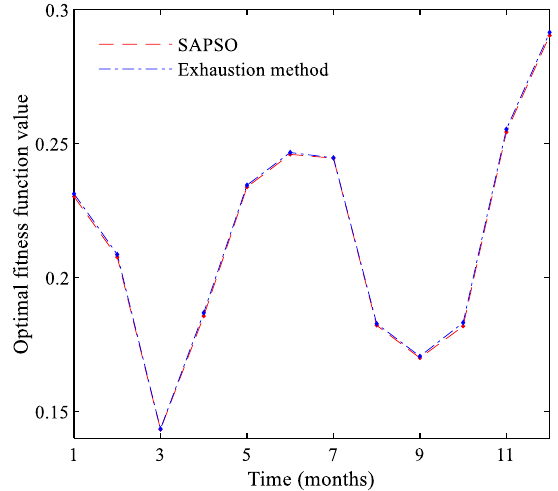
Fig. 6 Comparison between exhaustion method and SAPSO